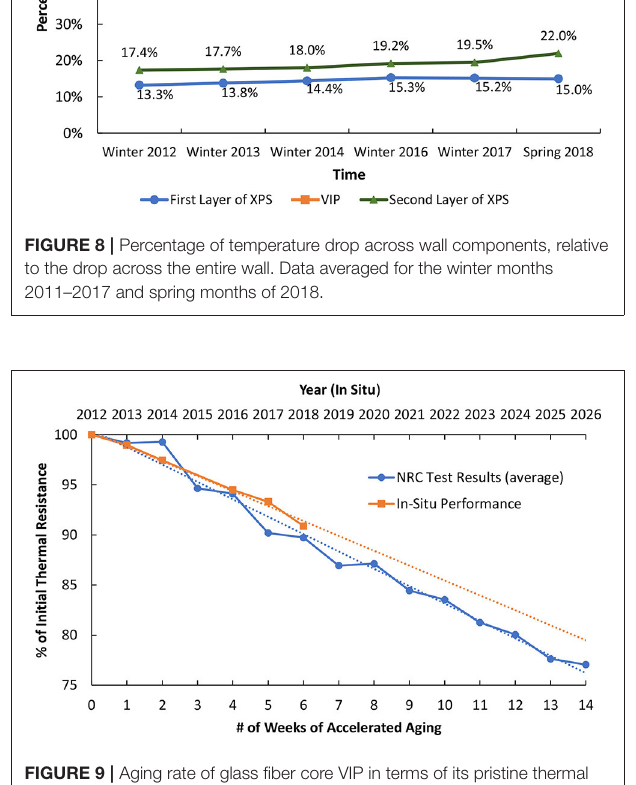
FIGURE 9 | Aging rate of glass fiber core VIP in terms of its pristine thermal resistance as a function of time determined from in situ performance and laboratory accelerated aging test results.